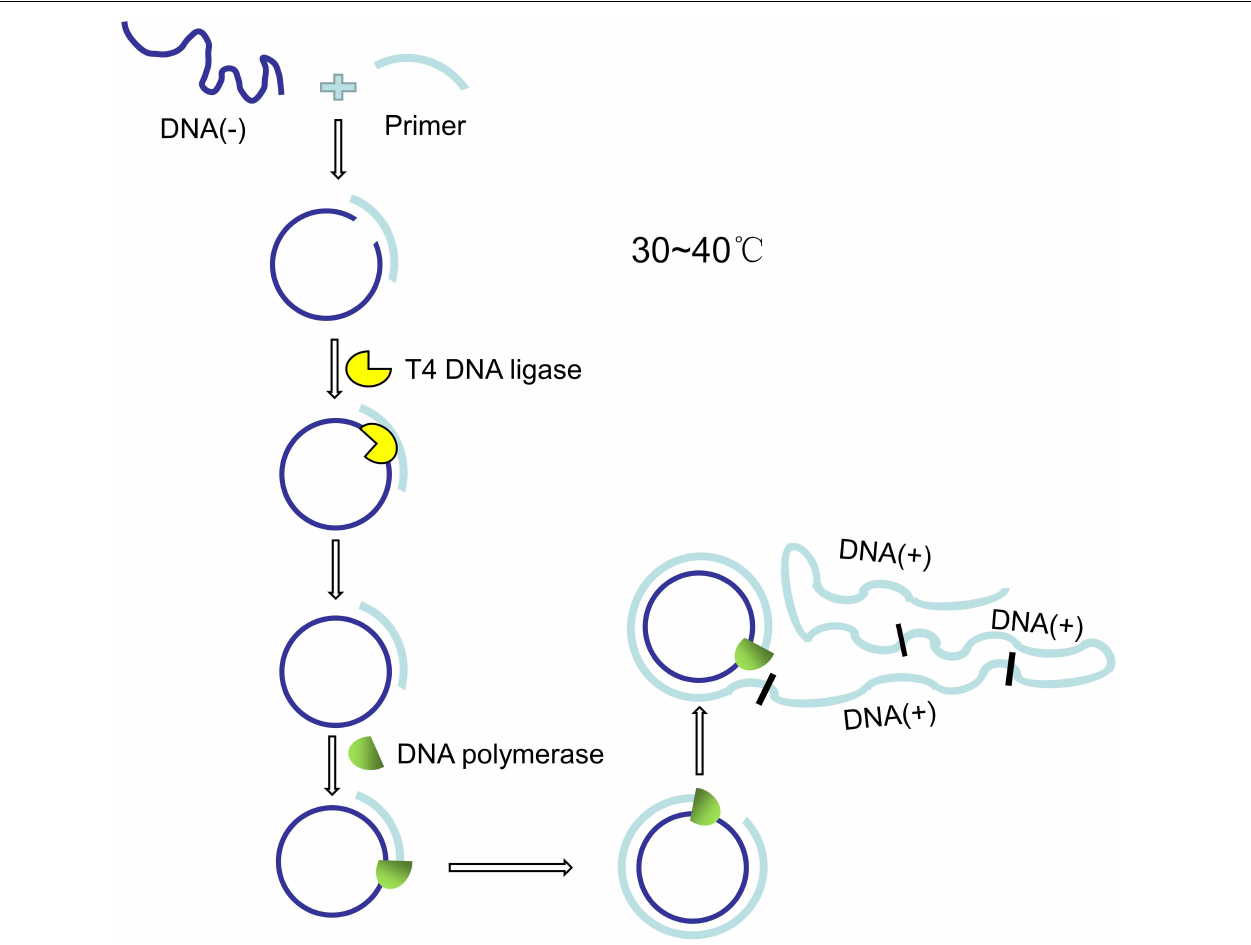
FIGURE 5 | Schematic diagram of rolling loop